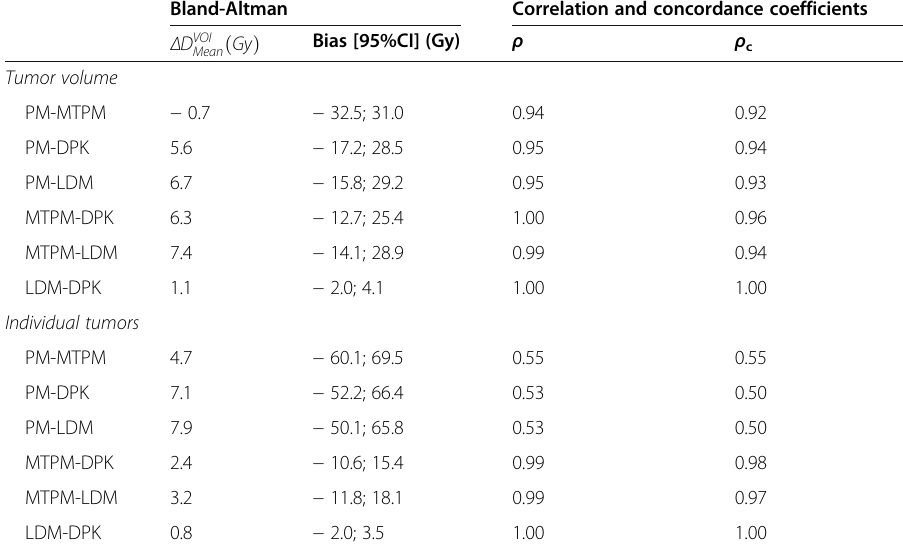
Table 5 Bland Altman analysis, Pearson ’ s correlation, and Lin concordance coefficients, of mean absorbed doses delivered to both tumoral liver and individual tumors volumes among the studied dosimetry methods (PM, MTPM, LDM, and DPK)